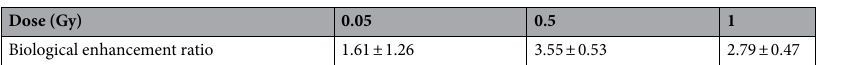
Table 1. Ratio of the mean number of radiation-induced MN (n = 12) at different dose points (Neutrons/ 60 Co). The propagation of uncertainty was calculated based on the standard deviations on the induced average MN